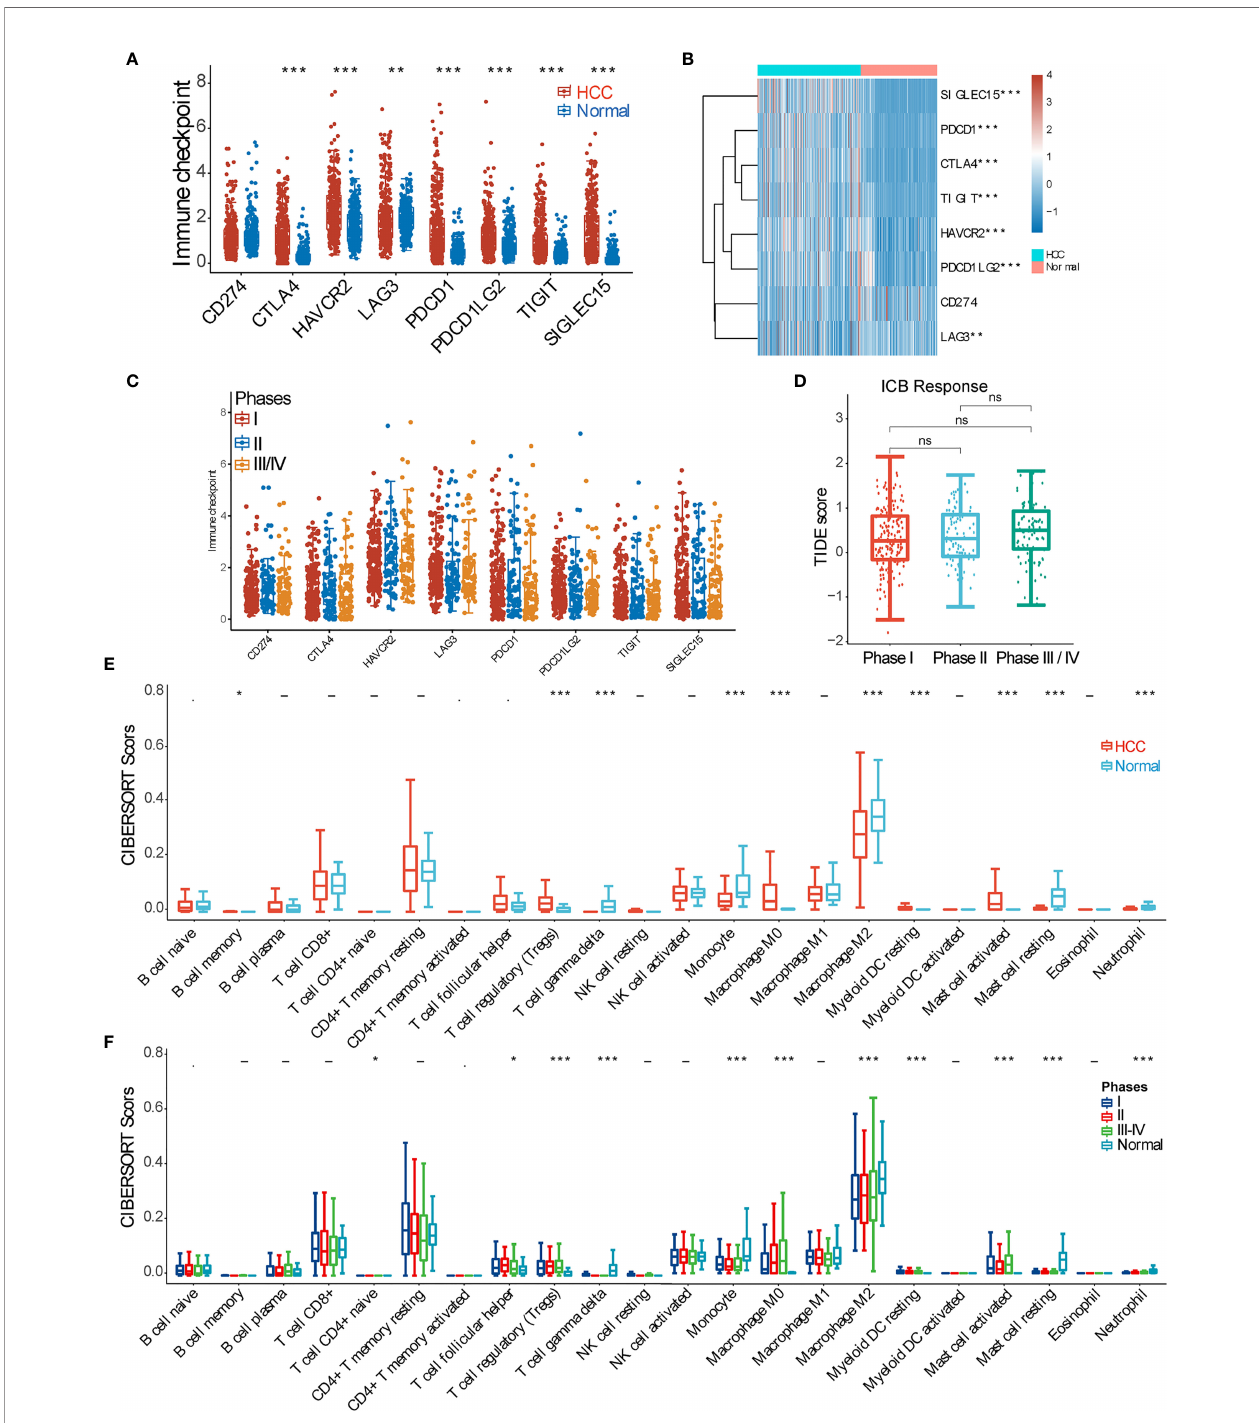
FIGURE 1 | Overview of the immune microenvironment of hepatocellular carcinoma (HCC) tissue. (A) Expression difference of inhibitory checkpoint molecules (CD274(PDL1), CTLA4, HAVCR2(TIM3), LAG3, PDCD1(PD1), PDCD1LG2(PDL2), TIGIT, and SIGLEC15) between HCC and normal tissue samples. (B) Heatmap of inhibitory checkpoint molecule expression. (C) Expression of inhibitory checkpoint molecules in HCC samples of pTNM stages I, II, and III – IV. (D) Tumor Immune Dysfunction and Exclusion (TIDE) score analysis was used to predict the responses to immune checkpoint blockade (ICB) of HCC patients at pTNM stages I, II, and III – IV. (E) CIBERSORT score of various immune cell in fi ltrations in HCC and normal tissue samples. (F) CIBERSORT score of various immune cell in fi ltrations among HCC samples of pTNM stages I, II, and III – IV. *p < 0.05; **p < 0.01; ***p < 0.001; ‘ - ’ , ns, no statistical signi fi